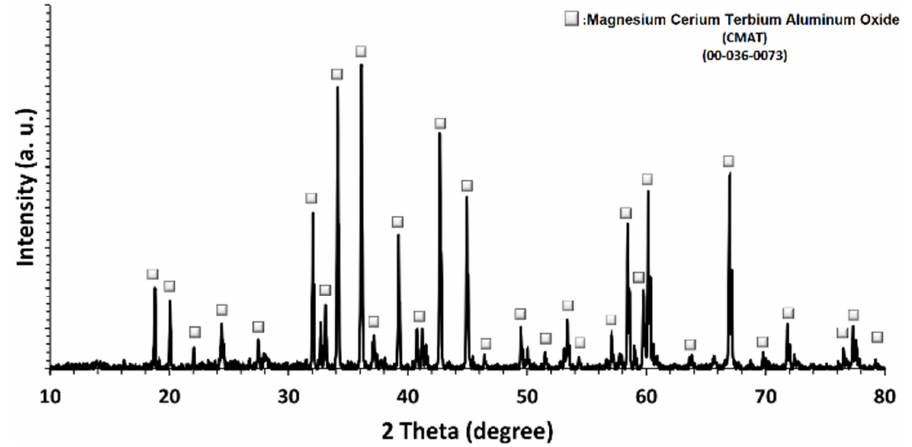
Figure 1. XRD pattern of synthesized CMAT powders after grinding.